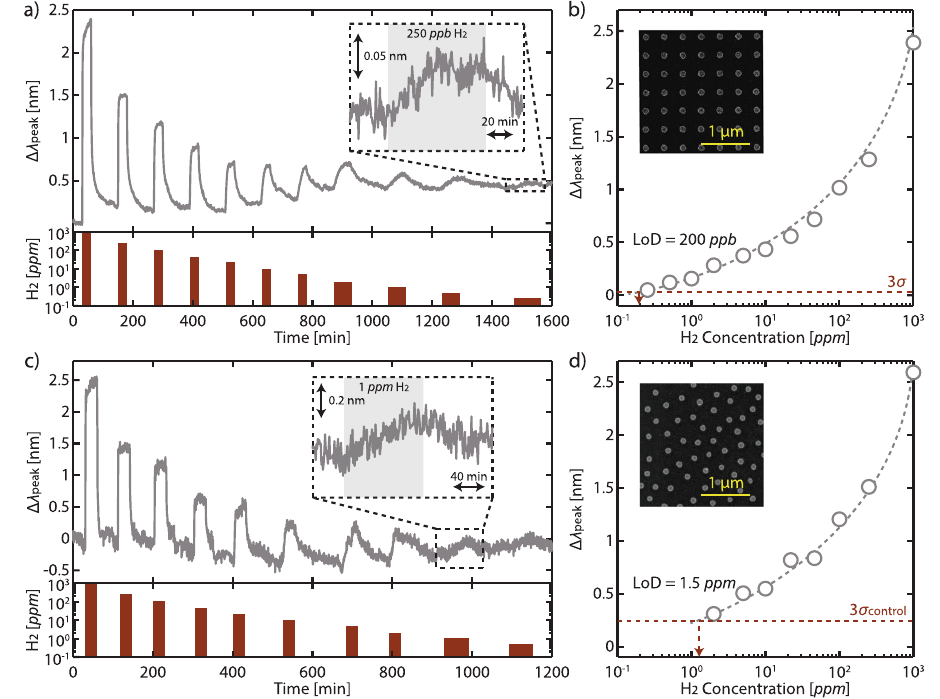
Fig.4|UltralowdetectionlimitwithPdperiodicarraysensor.a Δ λ peak response tostepwisedecreasingH 2 concentration(1000 – 0.25ppm)inArcarriergasatroom temperature. Inset: zoomed-in version of the sensor response to 250 ppb H 2 . The slightbaselinedriftlikelyarisefromminoradjustmentsinthesetupoverthecourse of the experiment 70 . b Measured Δ λ peak as a function of H 2 concentration derived from( a ).Graydashedlineisaguidetotheeyeandextrapolatesthesensorresponse